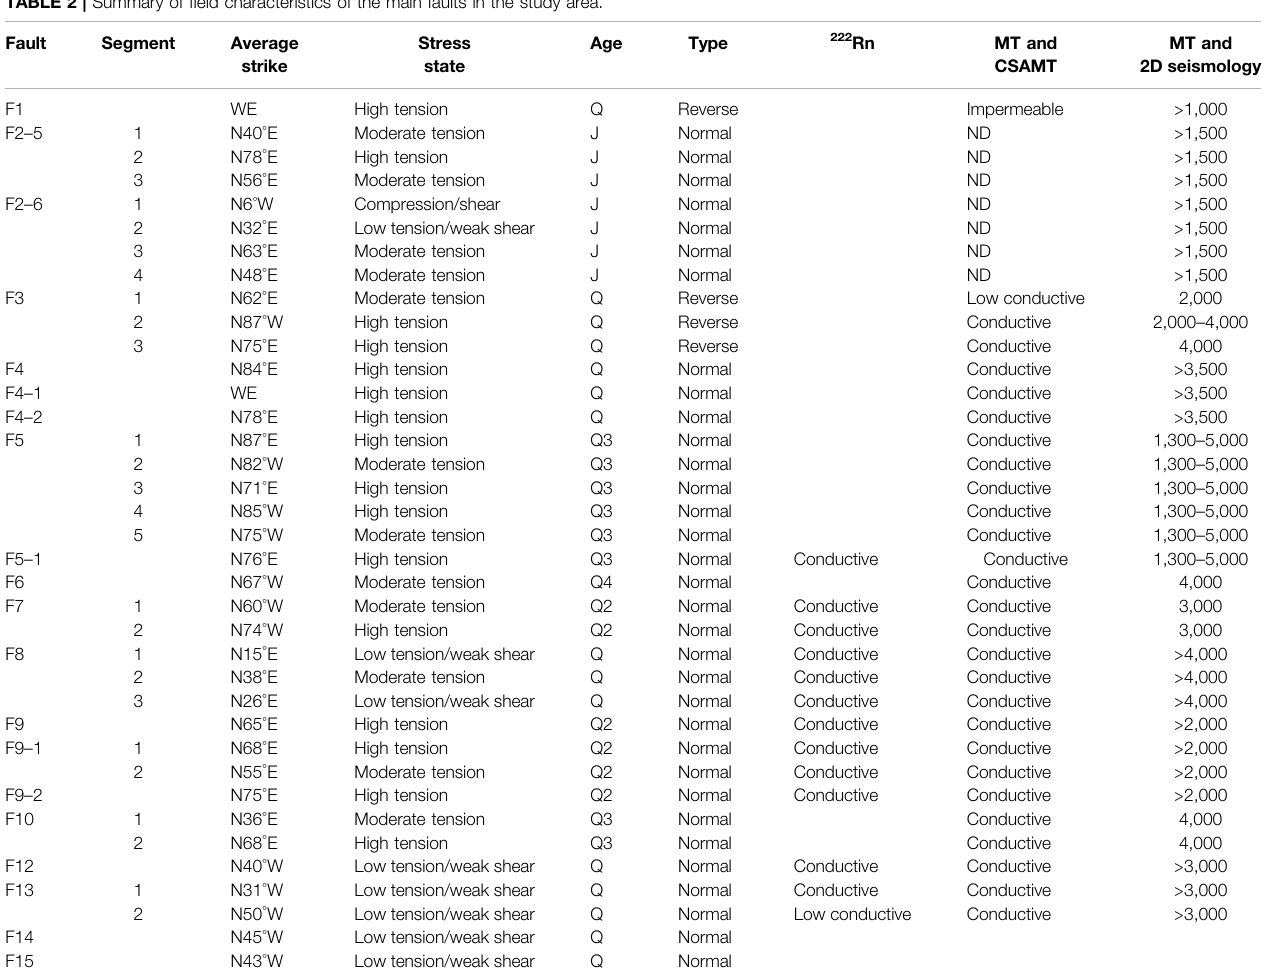
TABLE 2 | Summary of fi eld characteristics of the main faults in the study area.